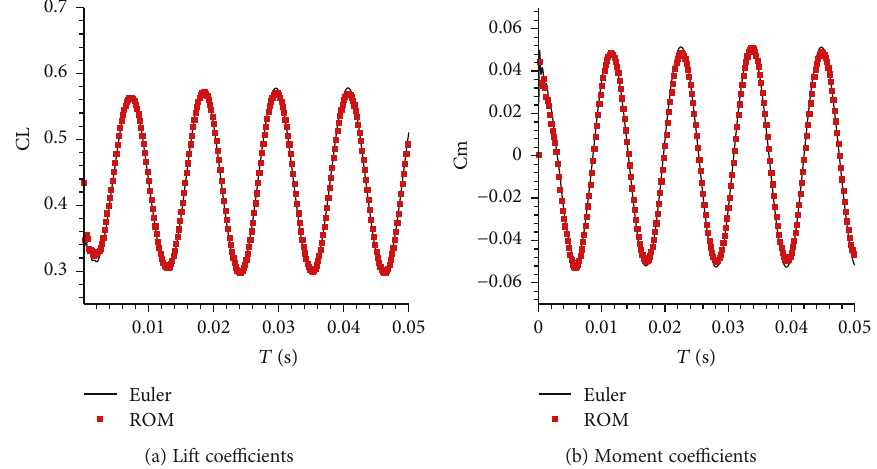
Figure 11: Comparison of the aerodynamic coe ffi cients obtained from Euler and ROM when f = 90